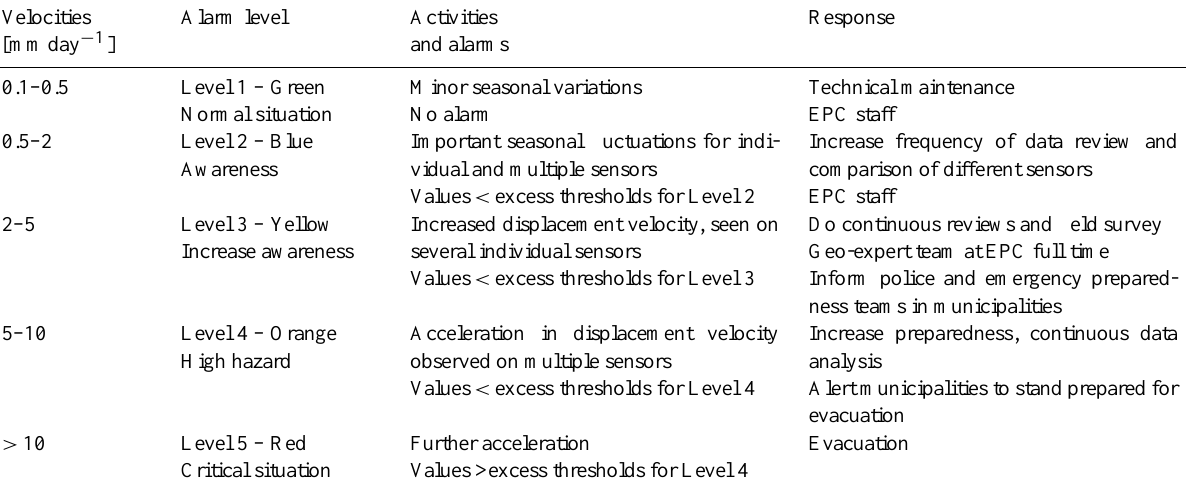
Table 2. Example from the Emergency Preparedness Centre in Stranda (Norway) of gradual alert levels based on different threshold values and expert evaluations leading to planned responses (modified from Blikra et al.,